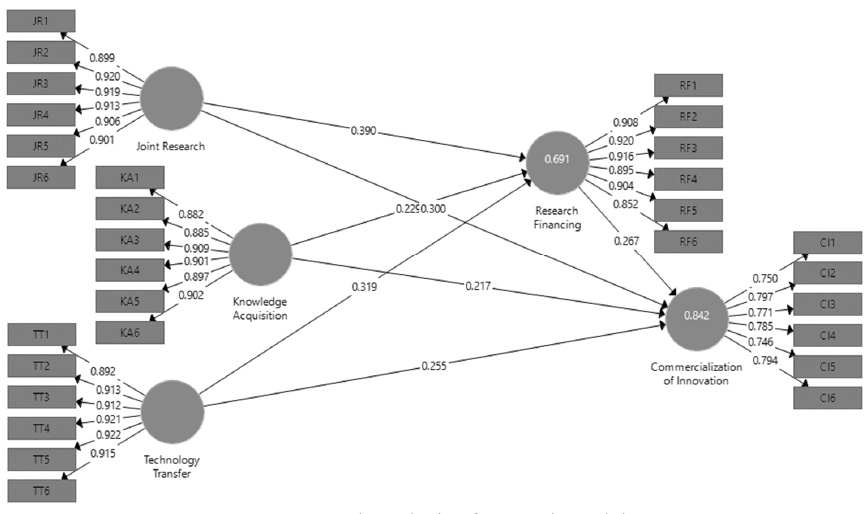
Fig. 2. Result analysis of research